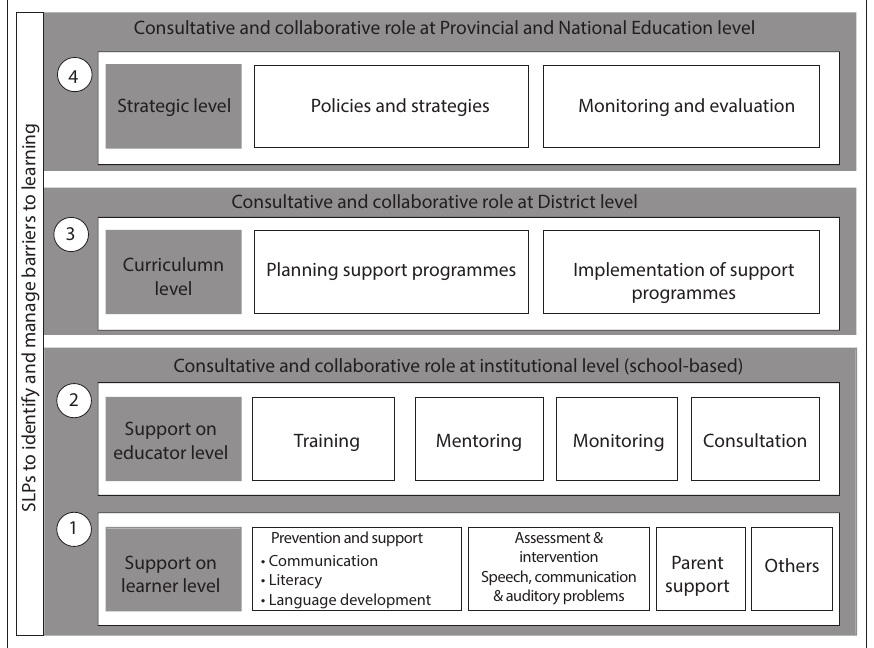
Fig. 2. Th e levels of collaboration of SLTs in the education